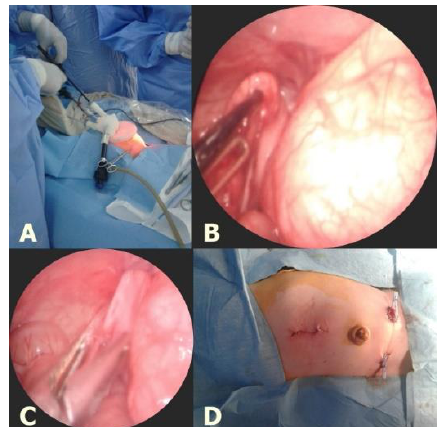
Figure 2:- (A) Standard straight laparoscopic instruments were introduced through the fingers of the glove port. (B) The most distal manoeuverable part of tortuous ureter was mobilised after making a hole in the overlying parietal peritoneum. (C) The ureter was grasped with a lararoscopic forceps and pulled to the surface. (D) Bilateral stoma at each end of suprapubic